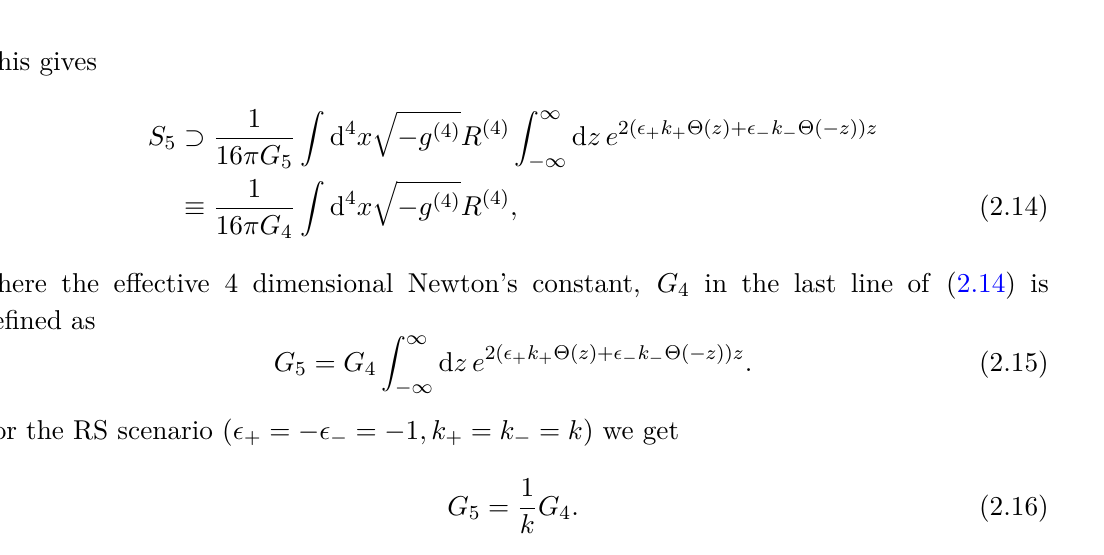
Figure 1. Warp factors for the shellworld vs the RS setup. The shellworld construction has an inside and an outside, as can be seen from the increasing warp factor beyond the position of the shell at z = 0 . The RS construction, on the other hand, has insides on both sides of the brane. Additionally, while the AdS spaces necessarily have different curvatures across the brane in the shellworld construction, the RS scenario has a Z 2 symmetry across the brane. The above plots are for k − = 3 , k + = 1 , and k rs = 3